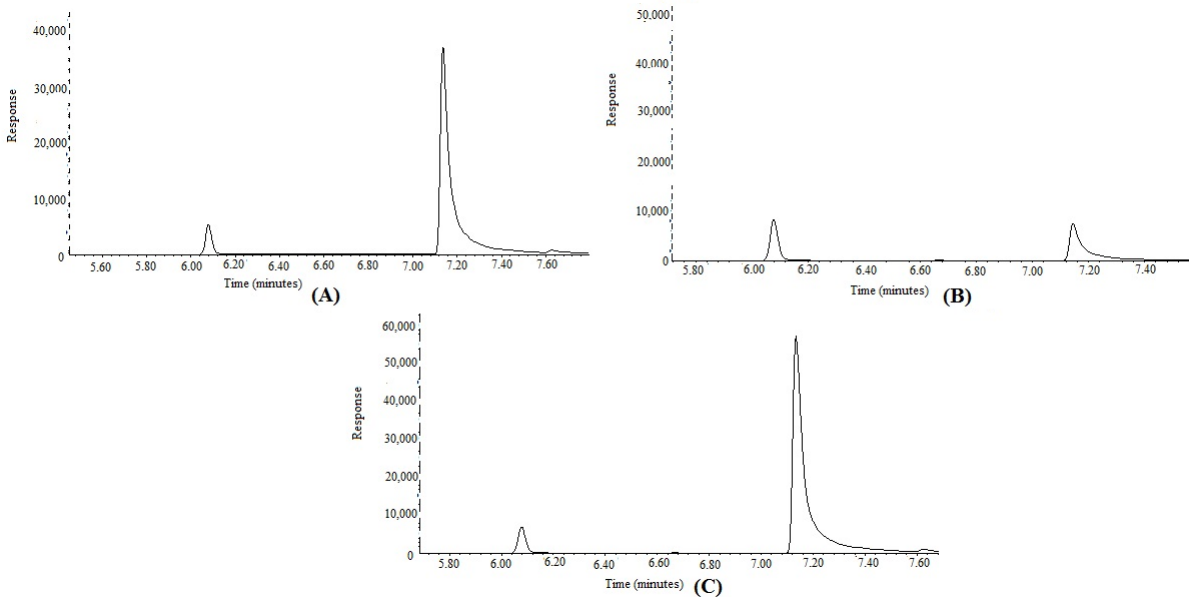
Figure 8. Representative GC-MS peaks of FCO and TOH in essential oils of F. vulgare obtained from ( A ) IND, ( B ) PAK, and ( C ) SA.